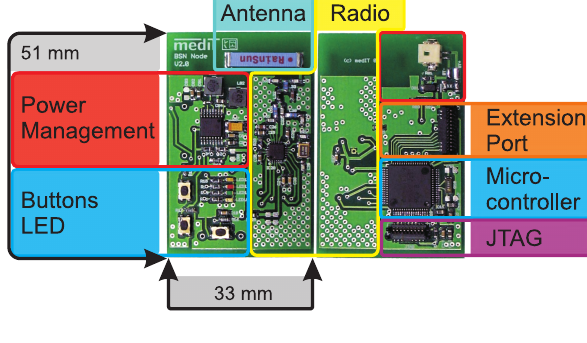
Figure 1. Functional units on the circuit board of an IPANEMA node generation